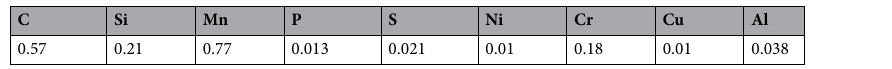
Table 1. Chemical composition (wt%) of a steel for gears used in this